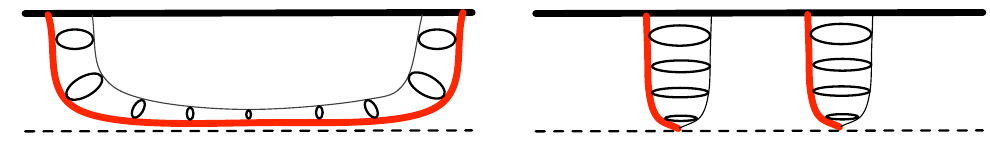
Figure 2 . (Left) Connected membrane con(cid:12)guration in the M-theory computation of the quark- antiquark potential. The thick, red curve represents the projection onto the non-compact directions. The black circles at each point illustrate the M-theory circle. The top, horizontal line is the boundary where the gauge theory is de(cid:12)ned. The bottom, dashed line is where the metric ends smoothly. (Right) Charge conservation allows the disconnected con(cid:12)guration, since the membrane closes o(cid:11) smoothly and therefore it has a boundaryless, cigar-like topology. Figure taken from